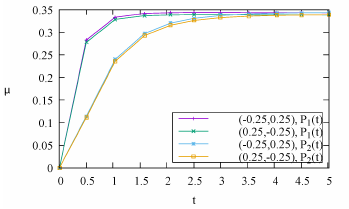
Figure 11. Solution µ at points ( − 0 . 25 , 0 . 25) , (0 . 25 , − 0 . 25) for Problem 2 of isotropic inhomogeneous